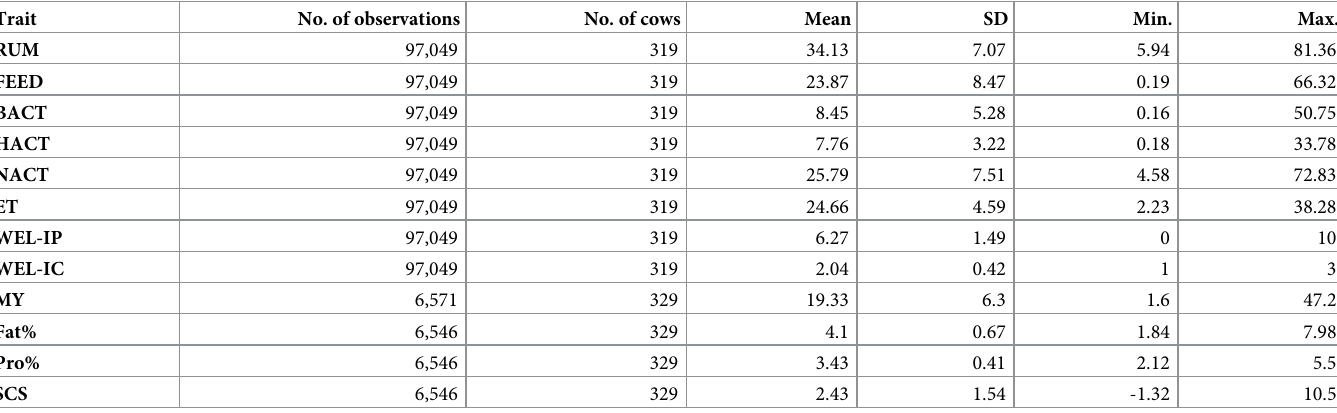
For the estimation of genetic parameters, genomic and pedigree relationship matrices were combined. In additional analyses, only the pedigree relationship matrix was considered. The pedigree consisted of 8,798 animals and was traced back as far as possible. The oldest ancestors in the pedigree were born in 1944 for Germany, in 1981 for Poland, in 1990 for Slovenia, and Table 7. Descriptive statistics for sensor behavior and production traits.